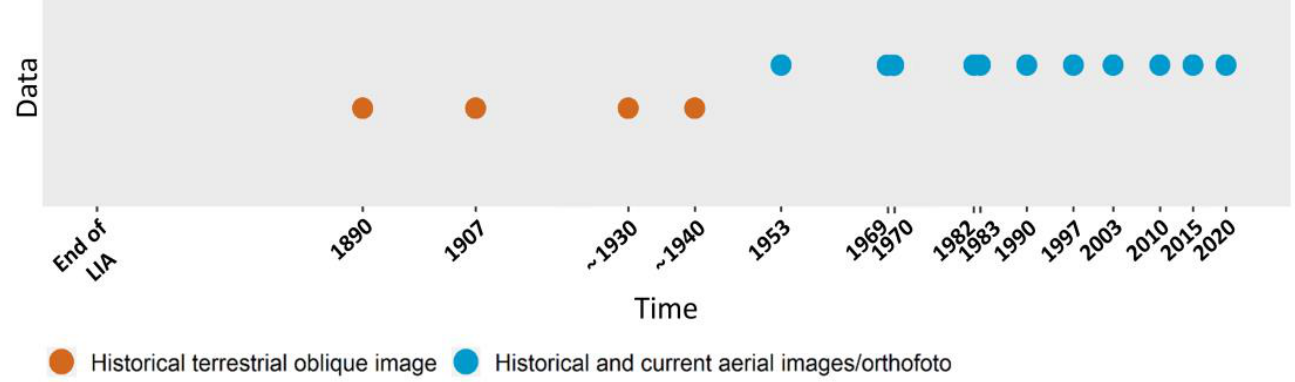
Figure 2. Overview of the temporal distribution of the analysed terrestrial and aerial photographs.